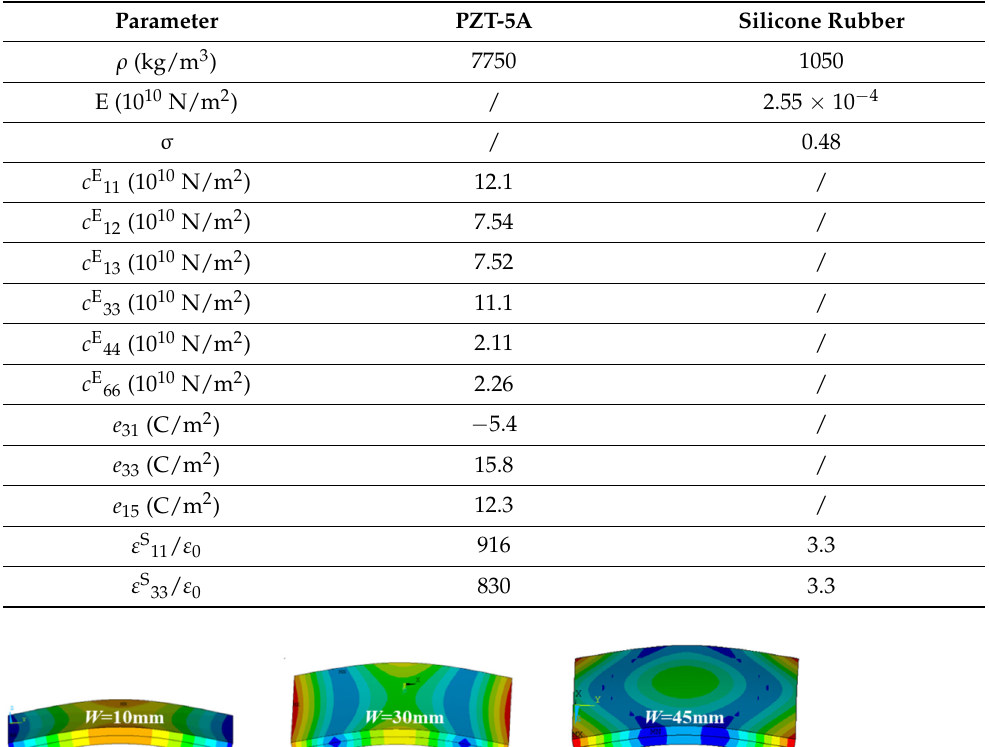
Figure 2. Bending vibration mode of piezoelectric ceramic double lamination.